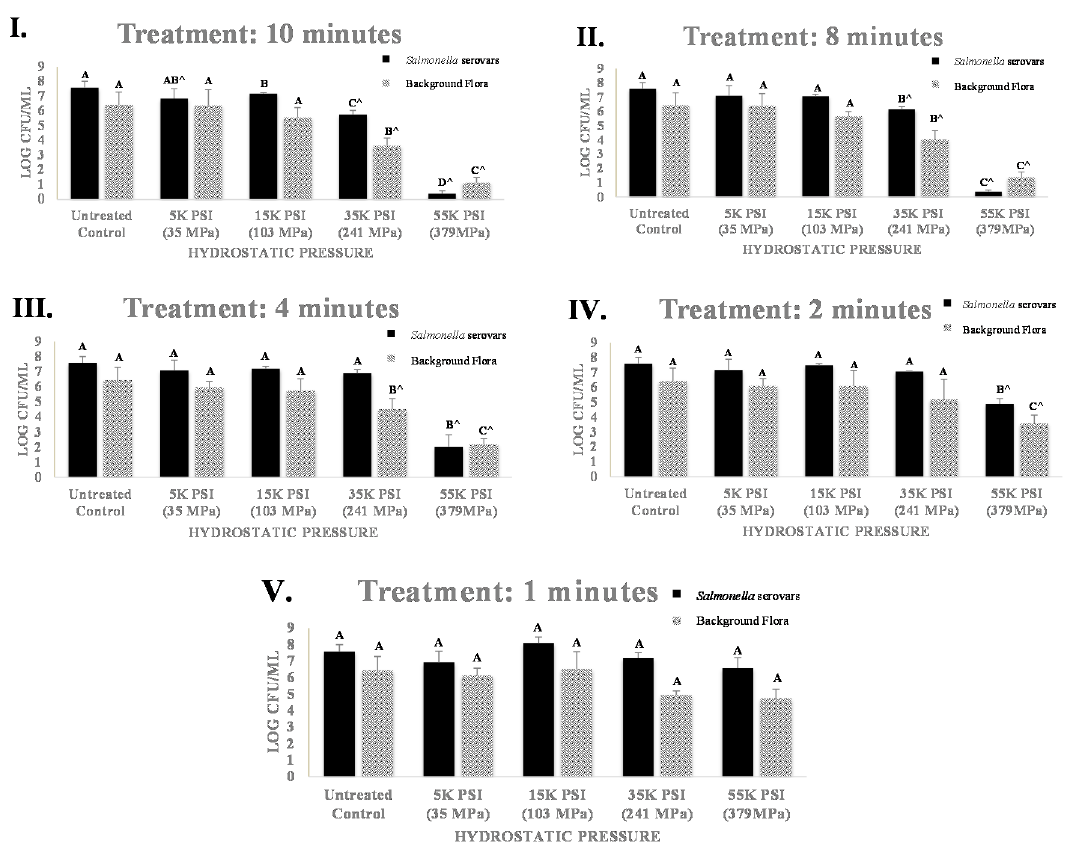
Figure 3. Effects of elevated hydrostatic pressure against five-strain habituated mixture of Salmonella serovars (ATCC ® numbers 13076, 8387, 6962, 9270, 14028) in sterilized orange juice and mesophilic background flora in non-sterile orange juice, treated (Barocycler Hub440, Pressure BioScience Inc., South Easton, MA, USA) at 25 °C For Salmonella serovars and mesophilic background flora separately. Columns of each time interval followed by different uppercase letters are representing log CFU/mL values that are statistically ( p < 0.05) different (Tukey-adjusted ANOVA). Uppercase letters followed by ˆ sign are statistically ( p < 0.05) different than the control (Dunnett-adjusted ANOVA). ( I ). Treatment for 10 min; ( II ). Treatment for 8 min; ( III ). Treatment for 4 min; ( IV ). Treatment for 2 min. ( V ); Treatment for 1 min; Black solid bars represent counts (mean ± SD) of Salmonella serovars, patterned bars represent counts associated with mesophilic background flora. The pH of samples were ranging from 3.75 ± 0.1 to 4.06 ± 0.1 and were similar ( p ≥ 0.05) among the various treated samples and control.